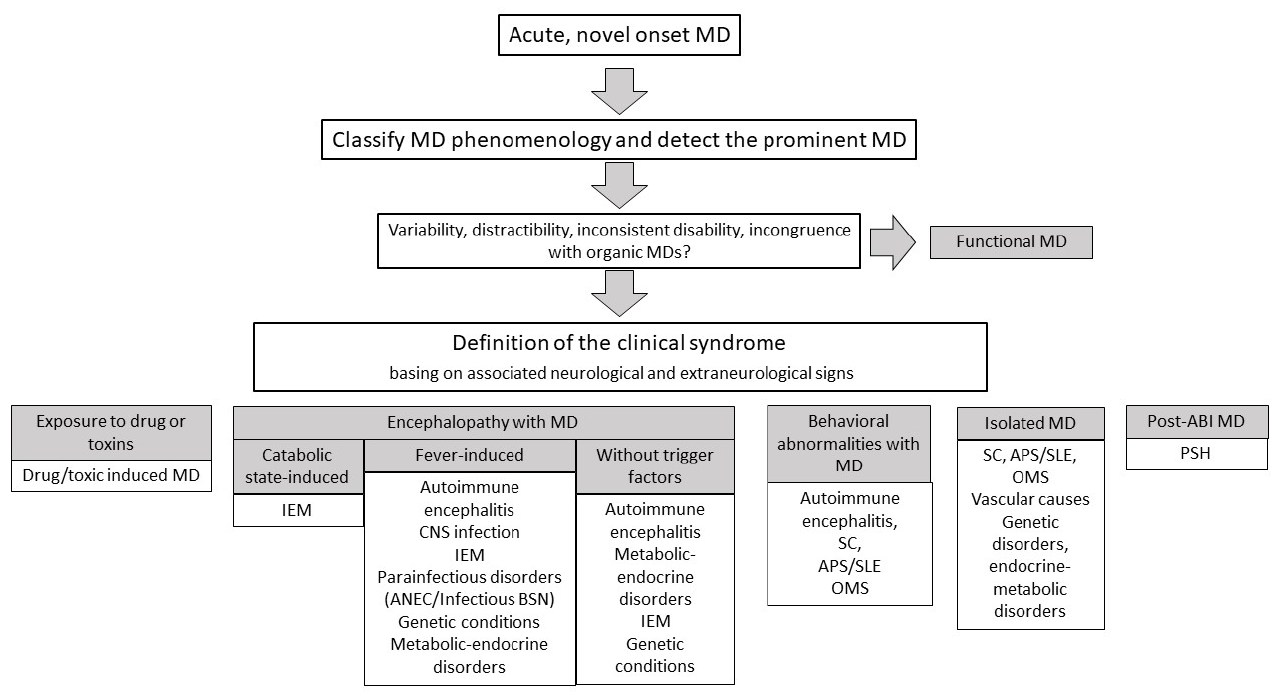
Figure 1. Clinical approach to acute-onset movement disorders. Based on the frequent clinical scenarios, the most relevant differential diagnoses are indicated. ANEC: acute necrotizing encephalopathy; APS: antiphospholipid syndrome; BSN: bilateral striatal necrosis; CNS: central nervous system; IEM: inborn errors of metabolism; OMS: opsoclonus–myoclonus syndrome; PSH: paroxysmal sympathetic hyperactivity; SC: Sydenham chorea; SLE: systemic lupus erythematosus.